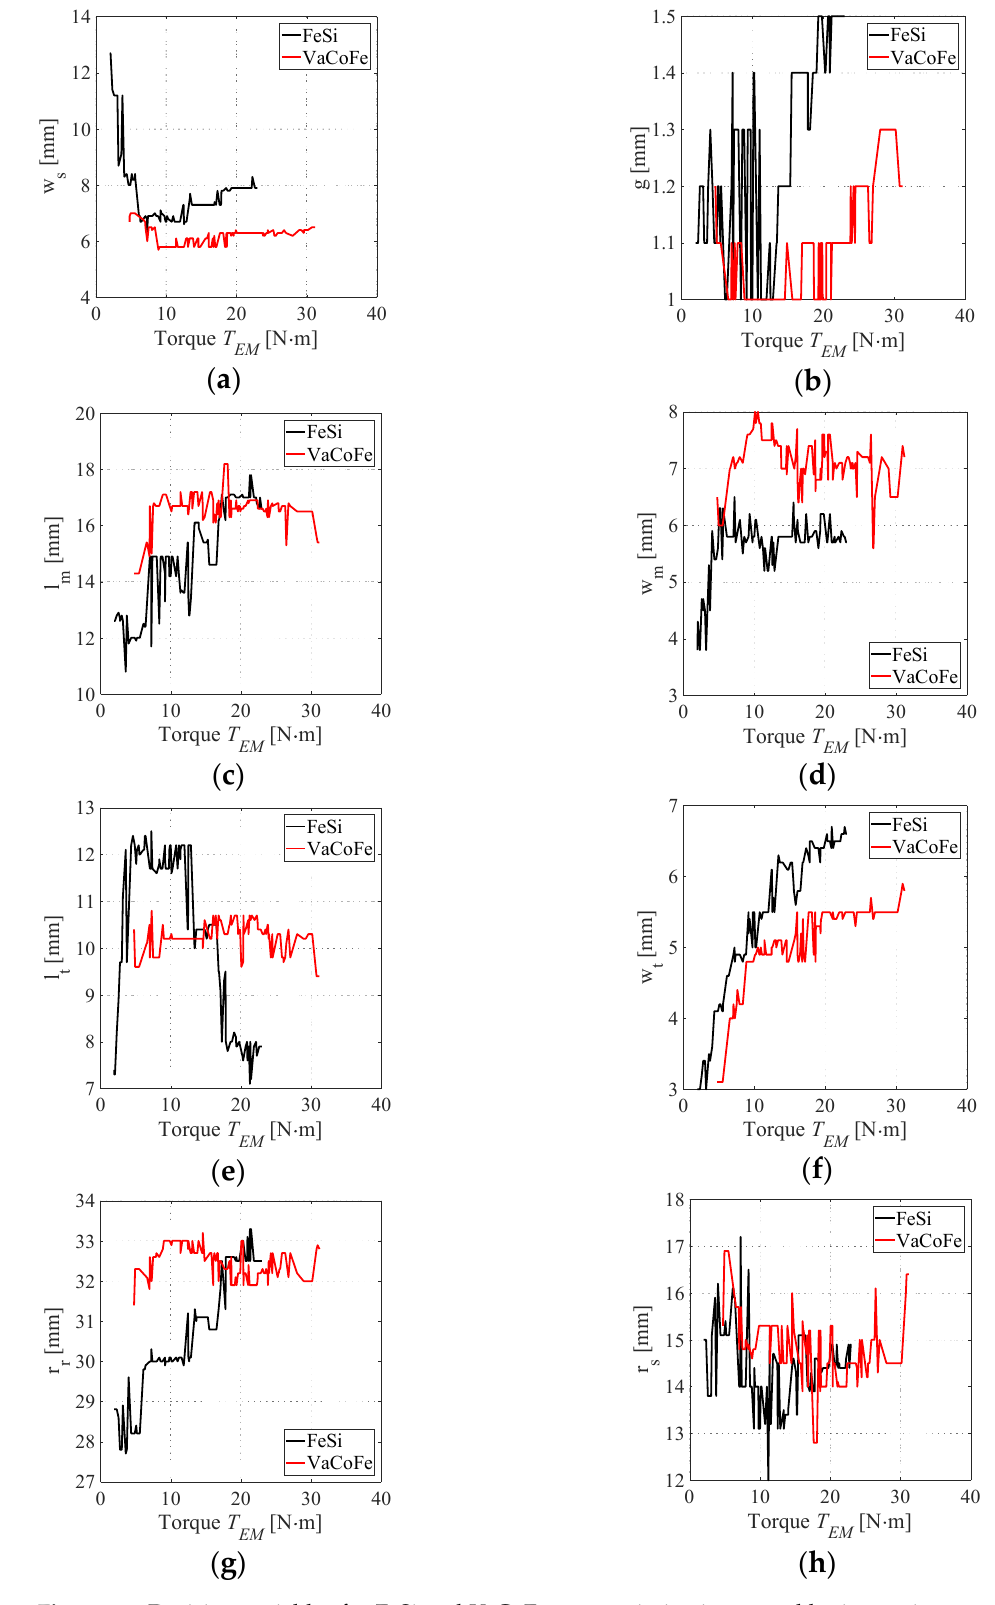
Figure 12. Decision variables for FeSi and VaCoFe core optimization sorted by increasing torque: ( a ) stator outer ring width w , ( b ) airgap size g , ( c ) magnet length l m , and ( d ) width w m , ( e ) stator teeth length l t and ( f ) width w t , ( g ) rotor radius r r and ( h ) shaft radius r s.